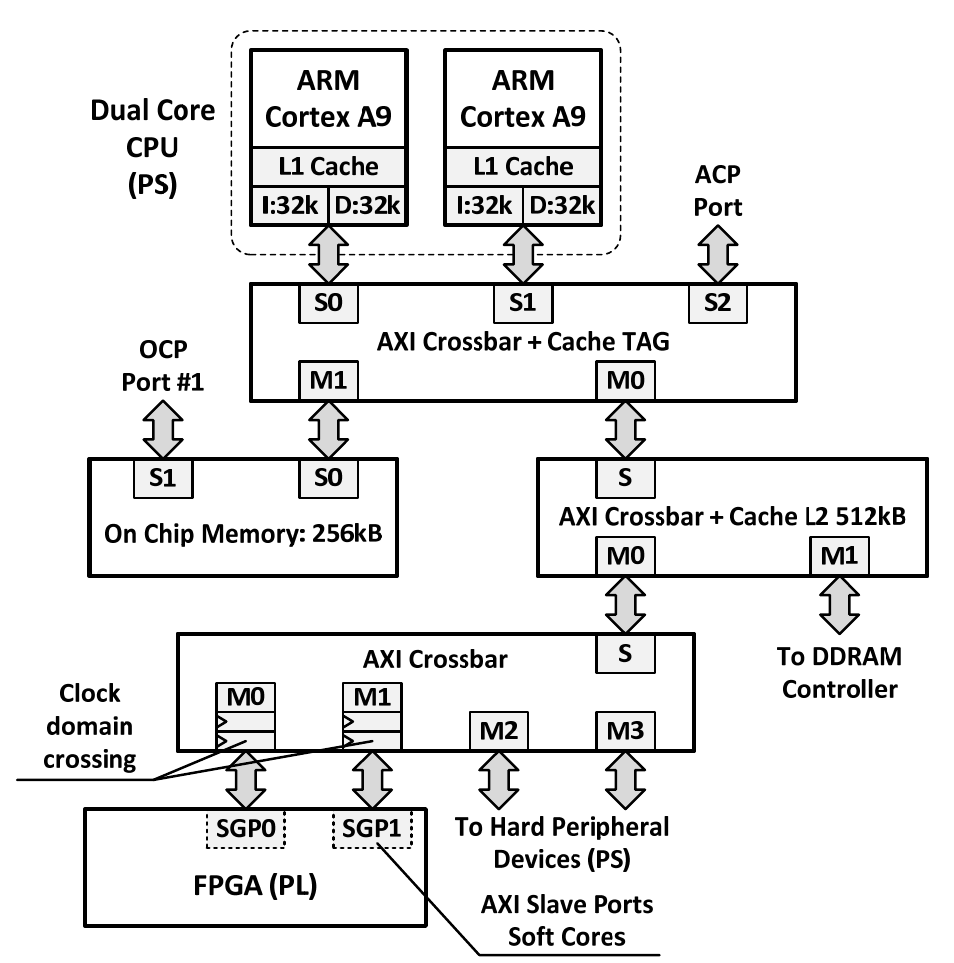
Figure 2. The ZYNQ device architecture. The connection between programmable system (processors) and programmable logic (FPGA) parts.